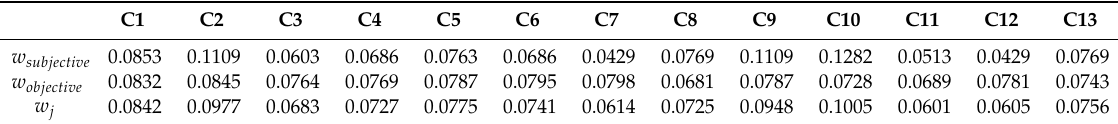
Table 6. Combination weights of evaluation criteria.